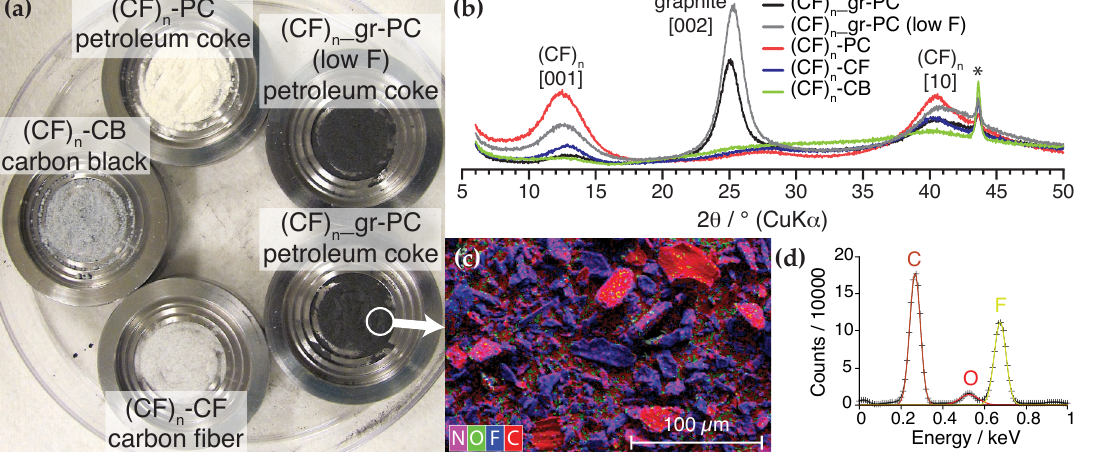
Figure 1. Characteristics of bulk poly(carbon monofluoride) samples. ( a ) Photographs of the five samples overlaid by their names and their carbon sources; ( b ) X-ray diffraction spectra for the